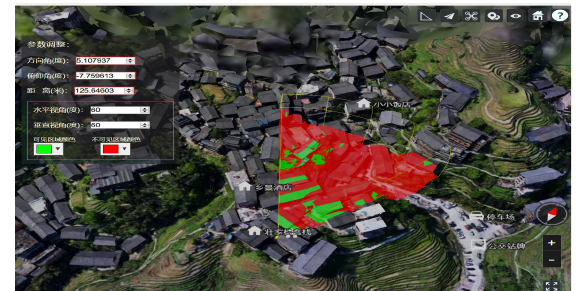
Figure 6. Spatial data